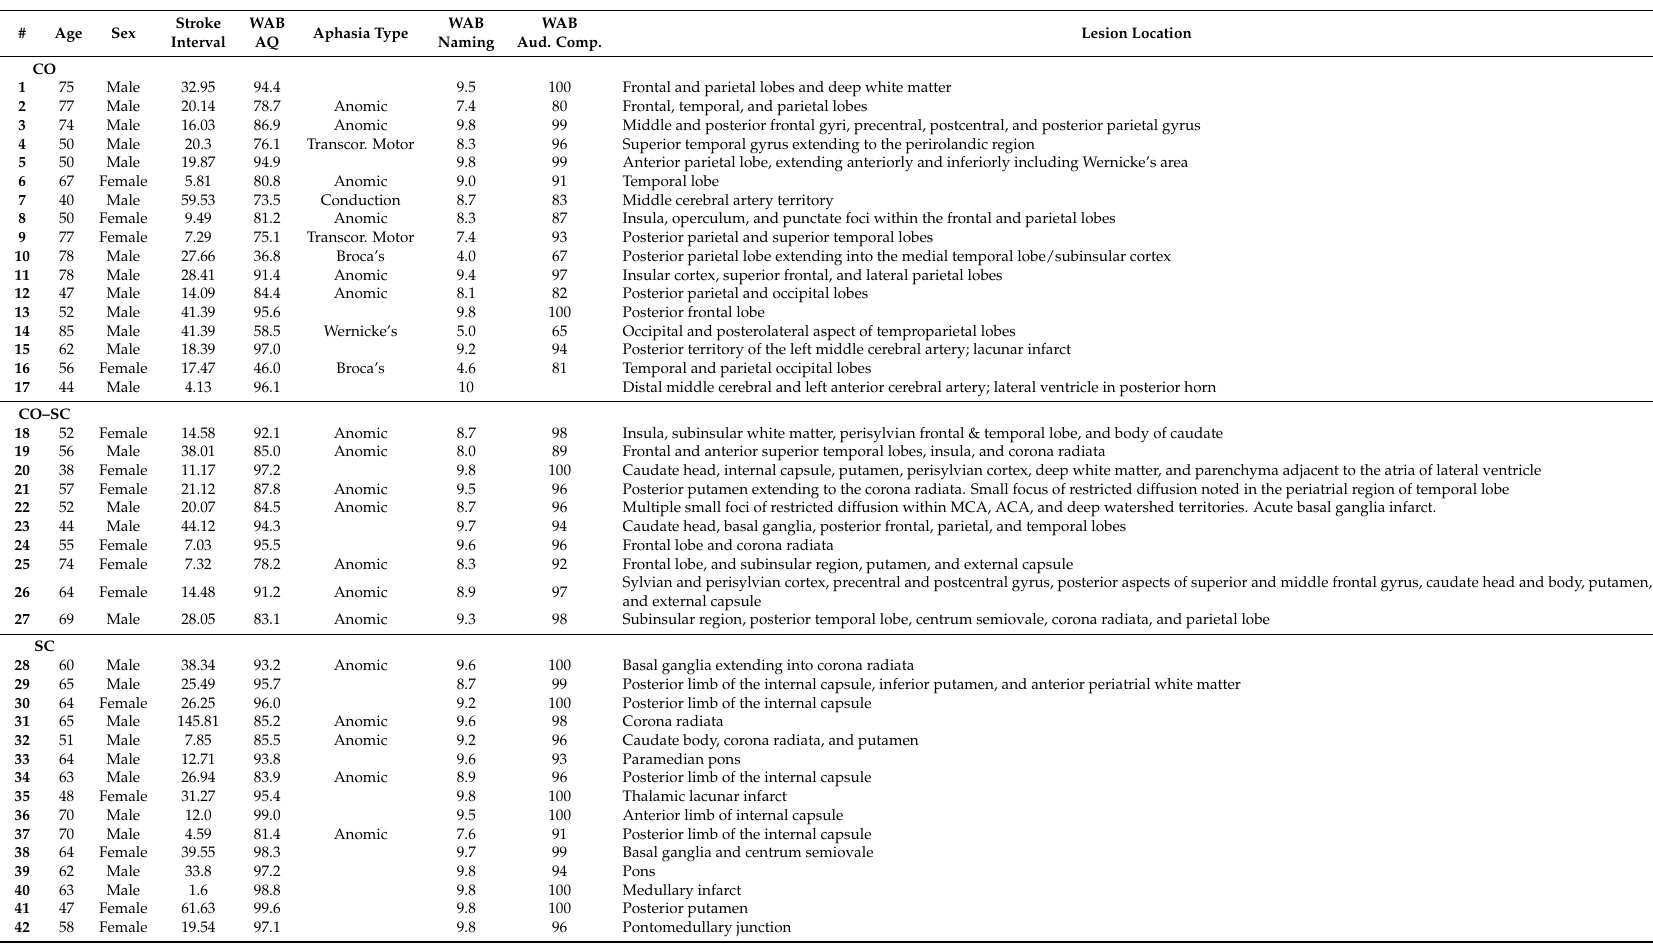
Table 1. Characteristics of left hemisphere stroke